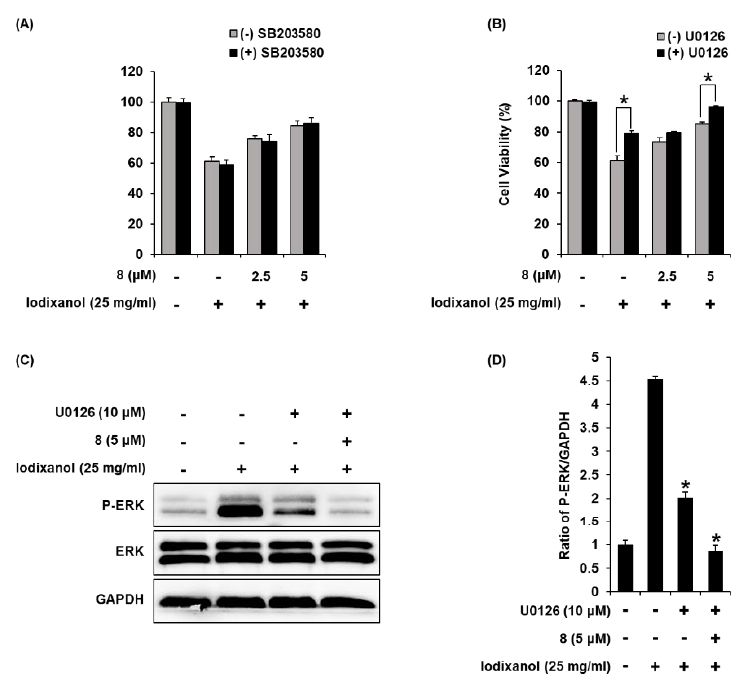
Figure 10. The effects of U0126 (ERK inhibitor) on the protective effects of 3- epi- iso -seco -tanapartholide Figure 10. The e ff ects of U0126 (ERK inhibitor) on the protective e ff ects of 3- epi -iso- seco -tanapartholide (compound 8 ) in iodixanol-induced cytotoxicity in LLC-PK1 cells. ( A and B ) Cells were treated with 25 mg/mL (compound 8 ) in iodixanol-induced cytotoxicity in LLC-PK1 cells. ( A ) and ( B ) Cells were treated with 25 mg / mL iodixanol and / or ( A ) SB203580 (P38 inhibitor, 15 µ M) or ( B ) U0126 (10 µ M) after iodixanol and/or (A) SB203580 (P38 inhibitor, 15 μM) or (B) U0126 (10 μM) after pre-treatment with compound pre-treatment with compound 8 (2.5 and 5 µ M) and cell viability was measured using an Ez-Cytox cell 8 (2.5 and 5 μM) and cell viability was measured using an Ez-Cytox cell viability assay kit (mean  SD, n = 3, * p viability assay kit (mean ± SD, n = 3, * p < 0.05 for di ff erences between the indicated pair of treatments. < 0.05 for differences between the indicated pair of treatments. ( C ) LLC-PK1 cells were treated with 25 mg/mL ( C ) LLC-PK1 cells were treated with 25 mg / mL iodixanol and / or U0126 (10 µ M) after pre-treatment iodixanol and/or U0126 (10 μM) after pre -treatment with compound 8 (5 μM) , and western blot analysis was with compound 8 (5 µ M), and western blot analysis was performed using antibodies for P-ERK, ERK, performed using antibodies for P-ERK, ERK, and GAPDH. ( D ) The ratios of ERK phosphorylation compared and GAPDH. ( D ) The ratios of ERK phosphorylation compared with untreated cells are represented as with untreated cells are represented as a bar graph (mean  SD, n = 3, * p < 0.05 compared with iodixanol-treated a bar graph (mean ± SD, n = 3, * p < 0.05 compared with iodixanol-treated LLC-PK1 LLC-PK1 cells).